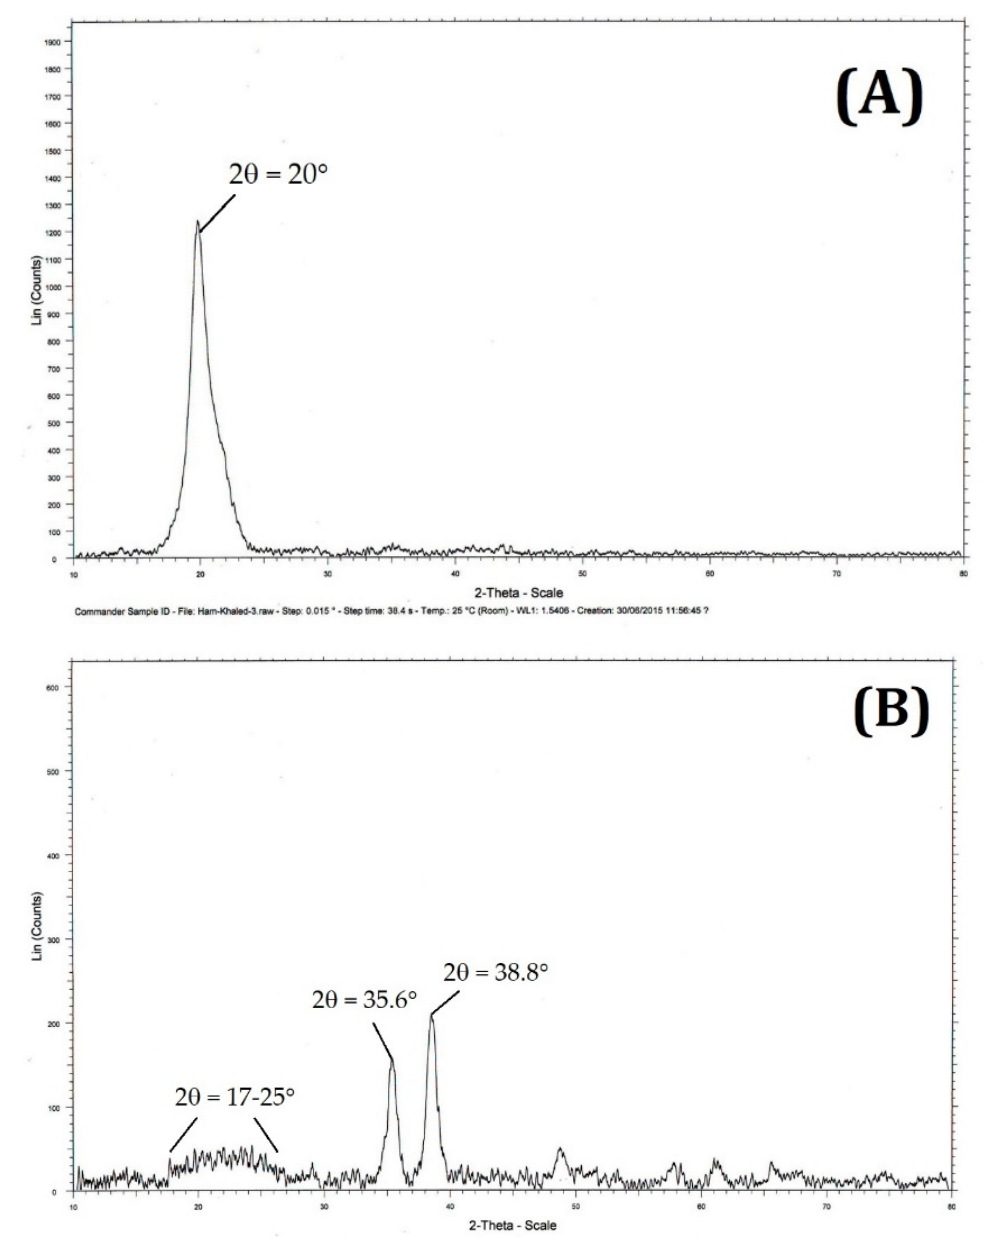
Figure 2. XRD of chitosan ( A ), and chitosan-CuO nanocomposite, (15 wt.%) ( B ).